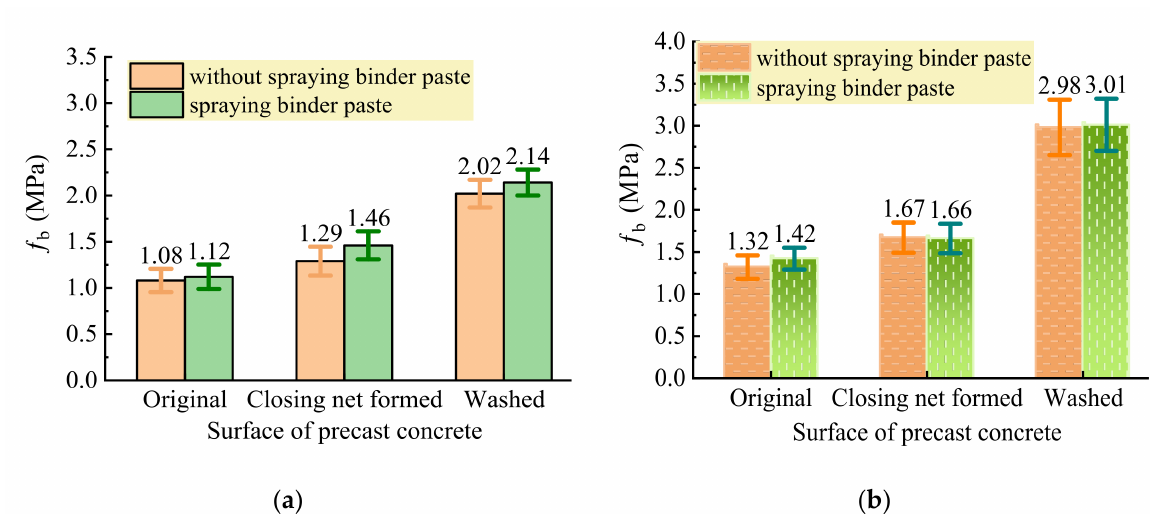
Figure 7. Comparison of bond strength of interface with or without adhesion agent: ( a ) C30 cast-in-situ concrete; ( b ) C40 cast-in-situ